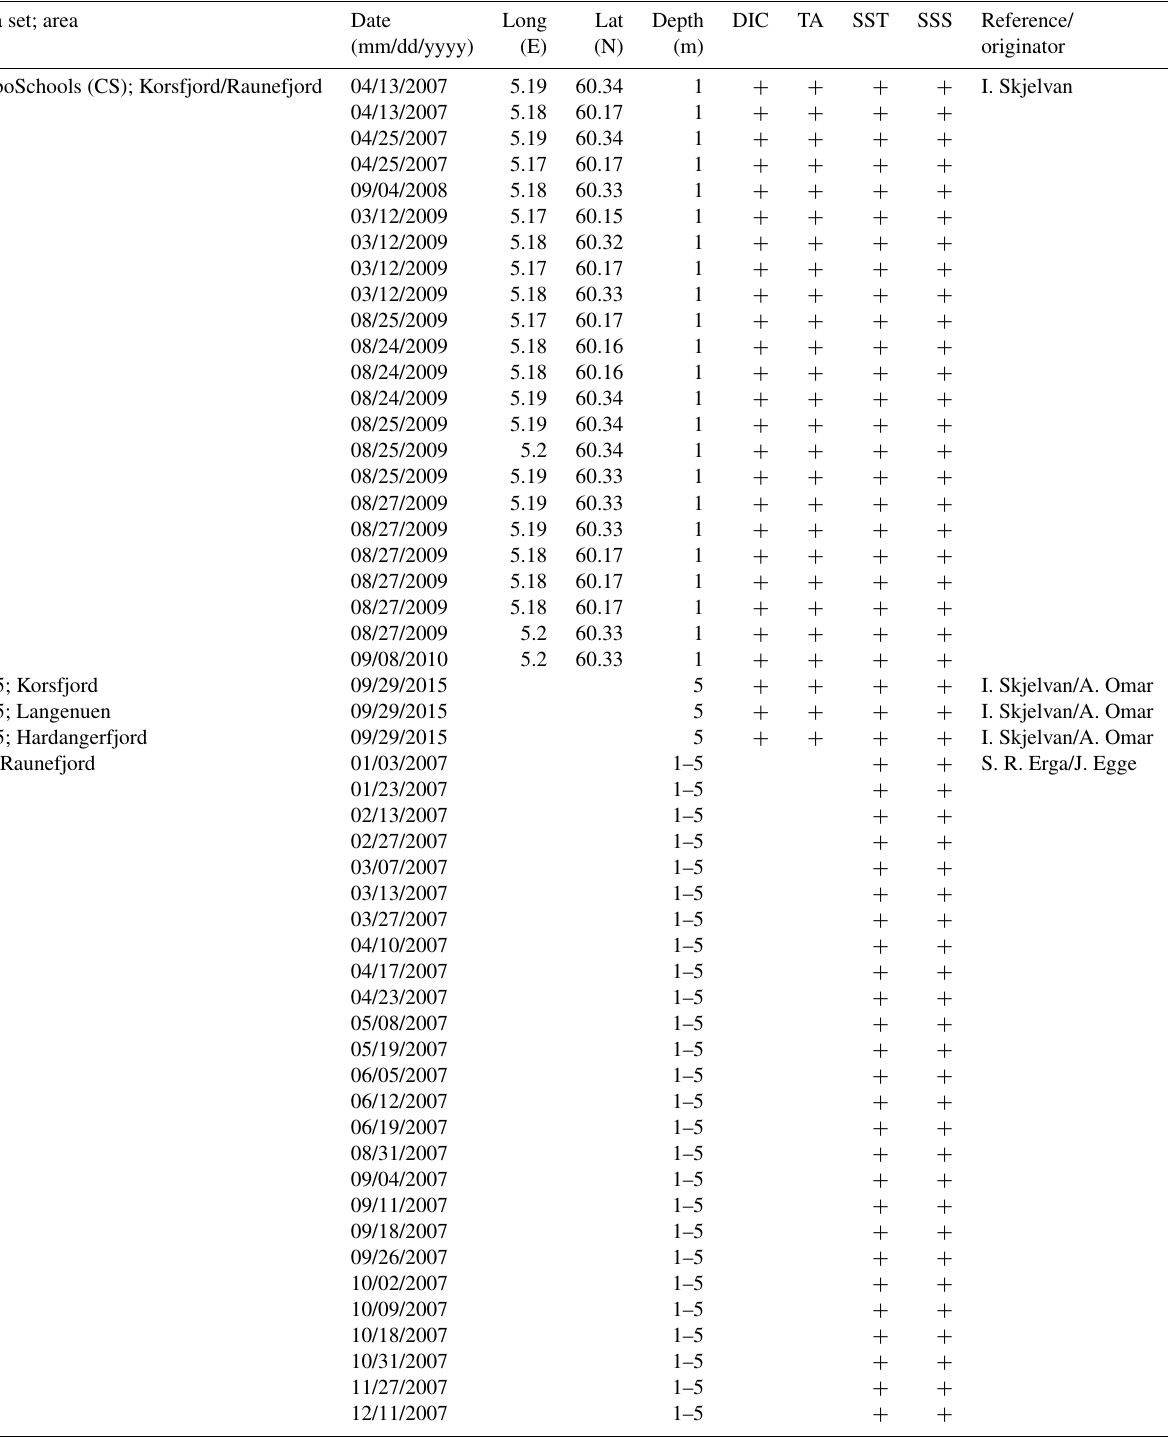
Table 1. Details of the CarboSchools (CS) and Raunefjord (RF) cruise data sets. The plus signs denote the parameters for which sam- pling/measurement were carried out. For the RF data set, each data point represents the average of five measurements acquired in the upper